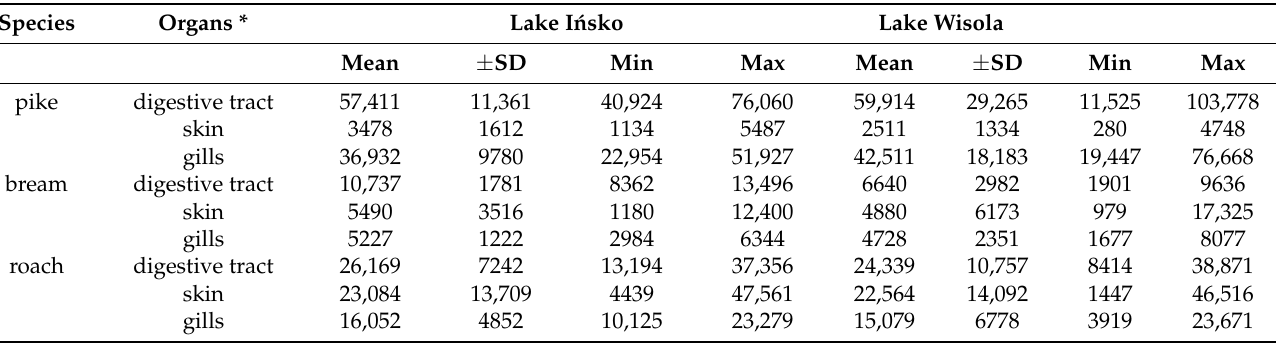
Table 6. Bioaccumulation factors ( BAF ).